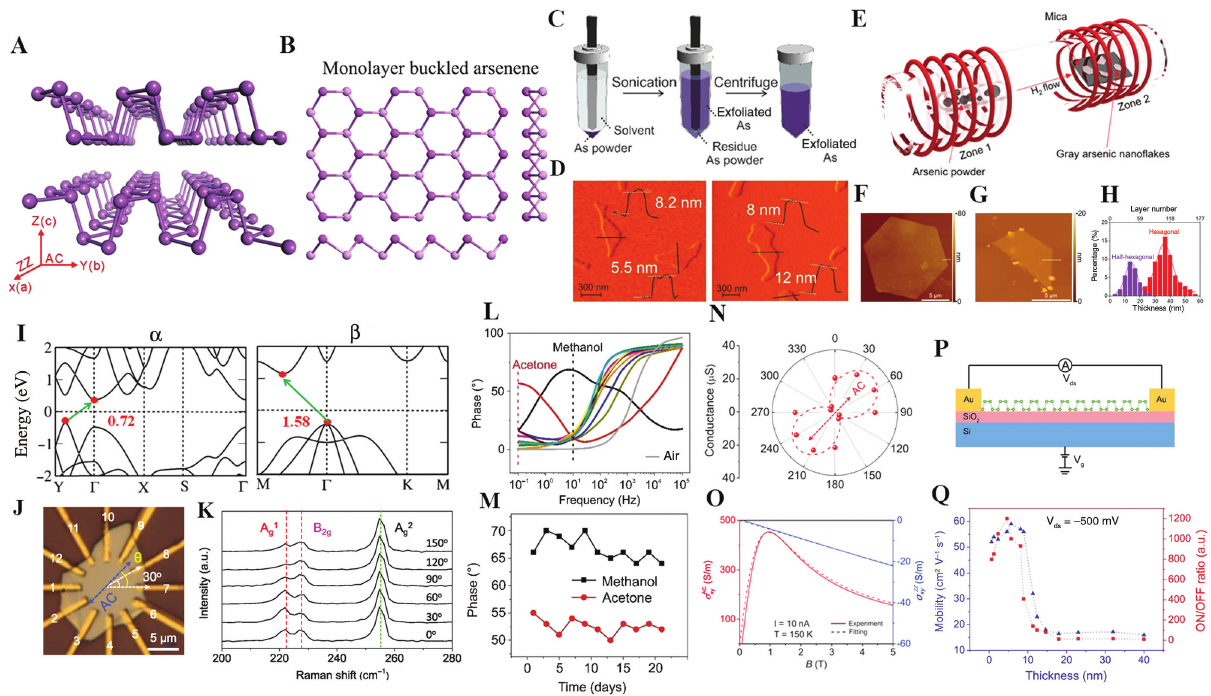
Figure 1: Structure, growth, physics and application of 2D As. (A) Layered crystal structure of puckered b-As. Reproduced with permission from Ref. [62]. Copyright 2018, Wiley-VCH. (B)